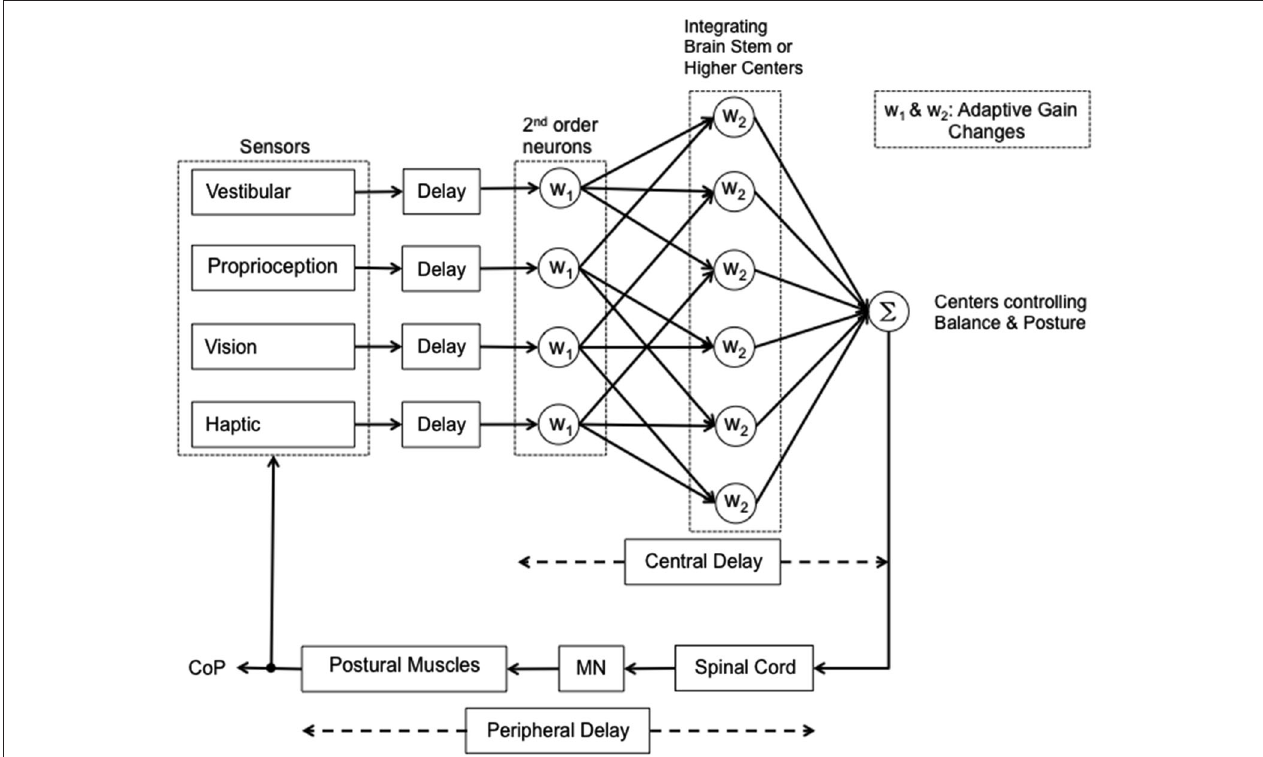
is transferred to the spinal cord interneuronal circuitry that generates the appropriate spatio-temporal pattern of muscle activity. This implies activation of MN activity and relevant muscle force, the effect of which is measured as displacement of the center of pressure (CoP). Most likely, the main part of the interval between the shift in sensory condition and the change in CoP displacement (approx. 1–2 s) conditional to active or passive addition or withdrawal of sensory information) depends on the operation of the central mechanisms generating the adaptive gain